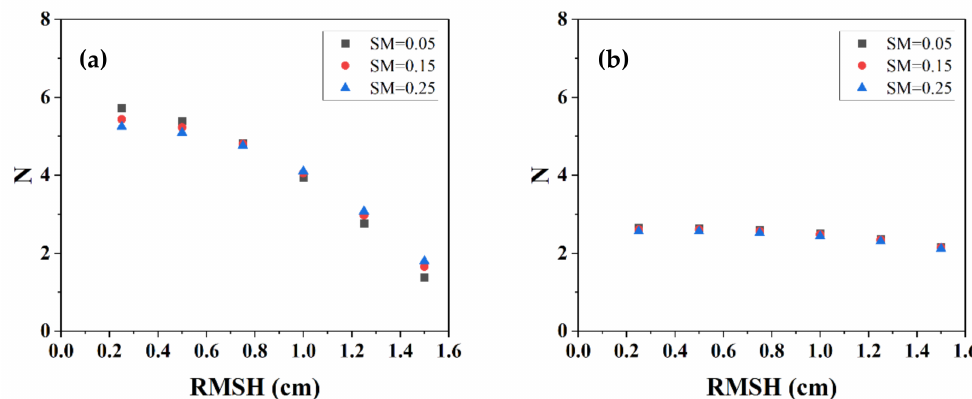
Figure 12. The influence of soil moisture and soil surface roughness parameter (root mean square height, RMSH) on N. ( a ) VV polarization; ( b ) HV